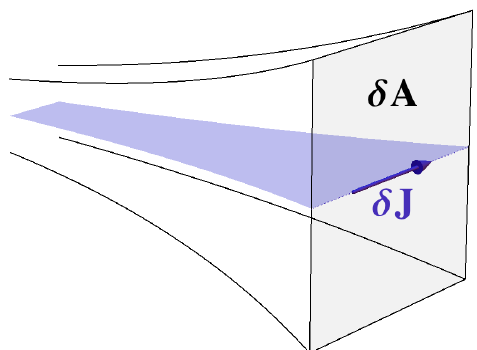
Figure 1: Schematics of a holographic setup for a physically realistic model for graphene. While the induced current δ J on the boundary is confined to 2 + 1 di- mensions, the boundary potential δ A lives in 3 + 1 dimensions. Therefore, a realistic holographic setup would require a brane-construction that keeps particles in place and electromagnetic phenomena are described by the bulk physics projected onto the